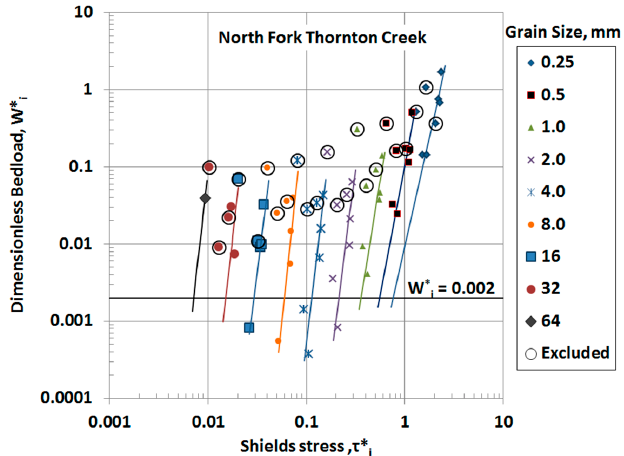
Figure 8. Dimensionless bedload versus Shields stress for the North Fork Thornton Creek. Samples marked with open circles are not consistent with the rest of the data due to differing site hydraulics, and were eliminated from the calibration process. This example is provided to show how the multi-grain-size modeling approach can be used to check data quality and sediment equilibrium assumptions.